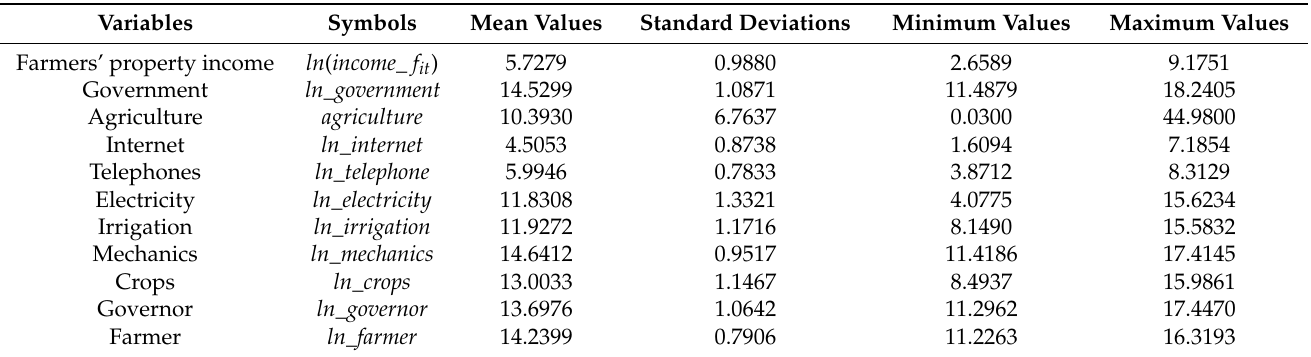
Table 1. Descriptive statistics for main